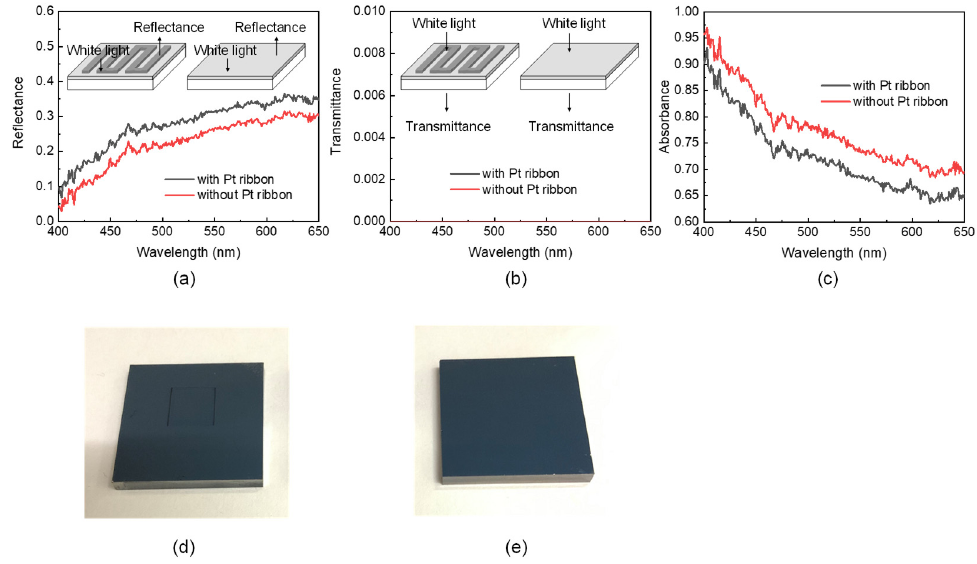
Figure 5. ( a ) Reflection, ( b ) transmission and ( c ) absorption spectra of FTO substrates with and without a Pt ribbon. Insets in ( a )[( b )] present the measurement of the reflection (transmission) spectra of the FTO substrates with and without a Pt ribbon. Photos of FTO substrates ( d ) with and ( e ) without a Pt ribbon.